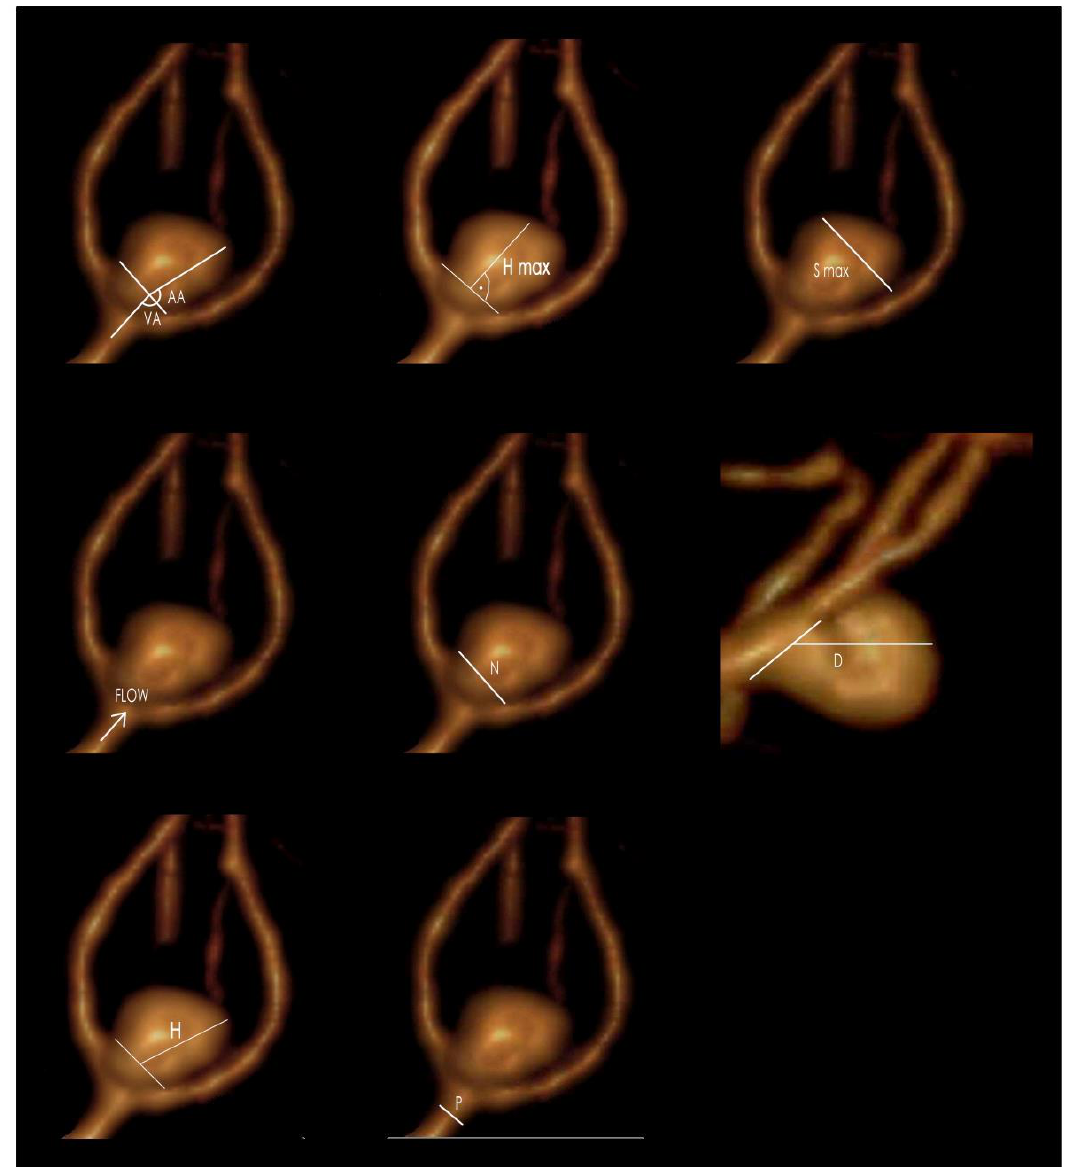
Figure 1. The morphometric parameters (flow—blood flow direction): S max—maximal aneurysm dome size; N—neck size; H—maximum aneurysm height, measured between the center of the aneurysm neck and the greatest distance to the aneurysm dome; H max—maximal perpendicular height, the largest perpendicular distance from the neck of the aneurysm to the dome of the aneurysm; P—parent artery diameter; AA—aneurysm angle; VA—vessel angle; D—maximum aneurysm depth (GIMP 2.10.22 DMG revision 3 for macOS).